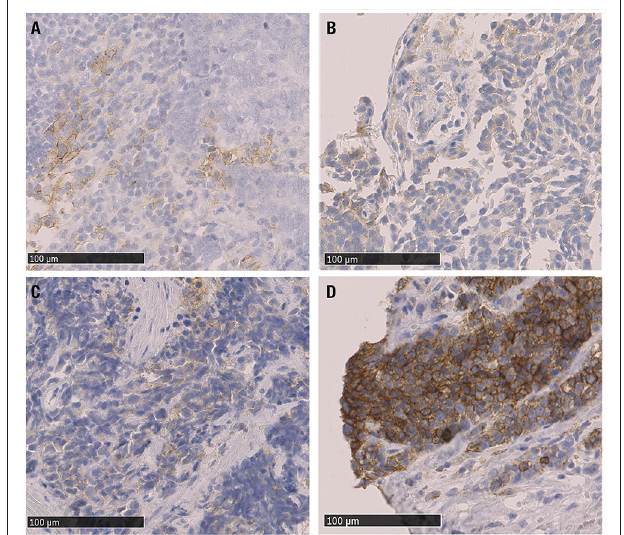
FIGURE 1 | Microphotographs of representative examples of IHC PD-L1 expression in NEN G3 samples; different levels of staining (brown) are shown. (A) PD-L1 positive TC (score 1 + ) (gastrinoma, distant metastasis), (B) PD-L1 positive IC (score 1 + ) and PD-L1 negative TC (Merkel cell carcinoma lymph node metastasis), (C) PDL1 positive TC and IC, both score 1 + (lung, primary tumor sample), (D) PD-L1 positive TC (score 3 + ) (colon MiNEN, distant metastasis). PD-L1: programmed cell death ligand 1, IHC: immunohistochemistry, TC: tumor cells, IC: tumor-infiltrating immune cells, MiNEN: mixed neuroendocrine-nonneuroendocrine